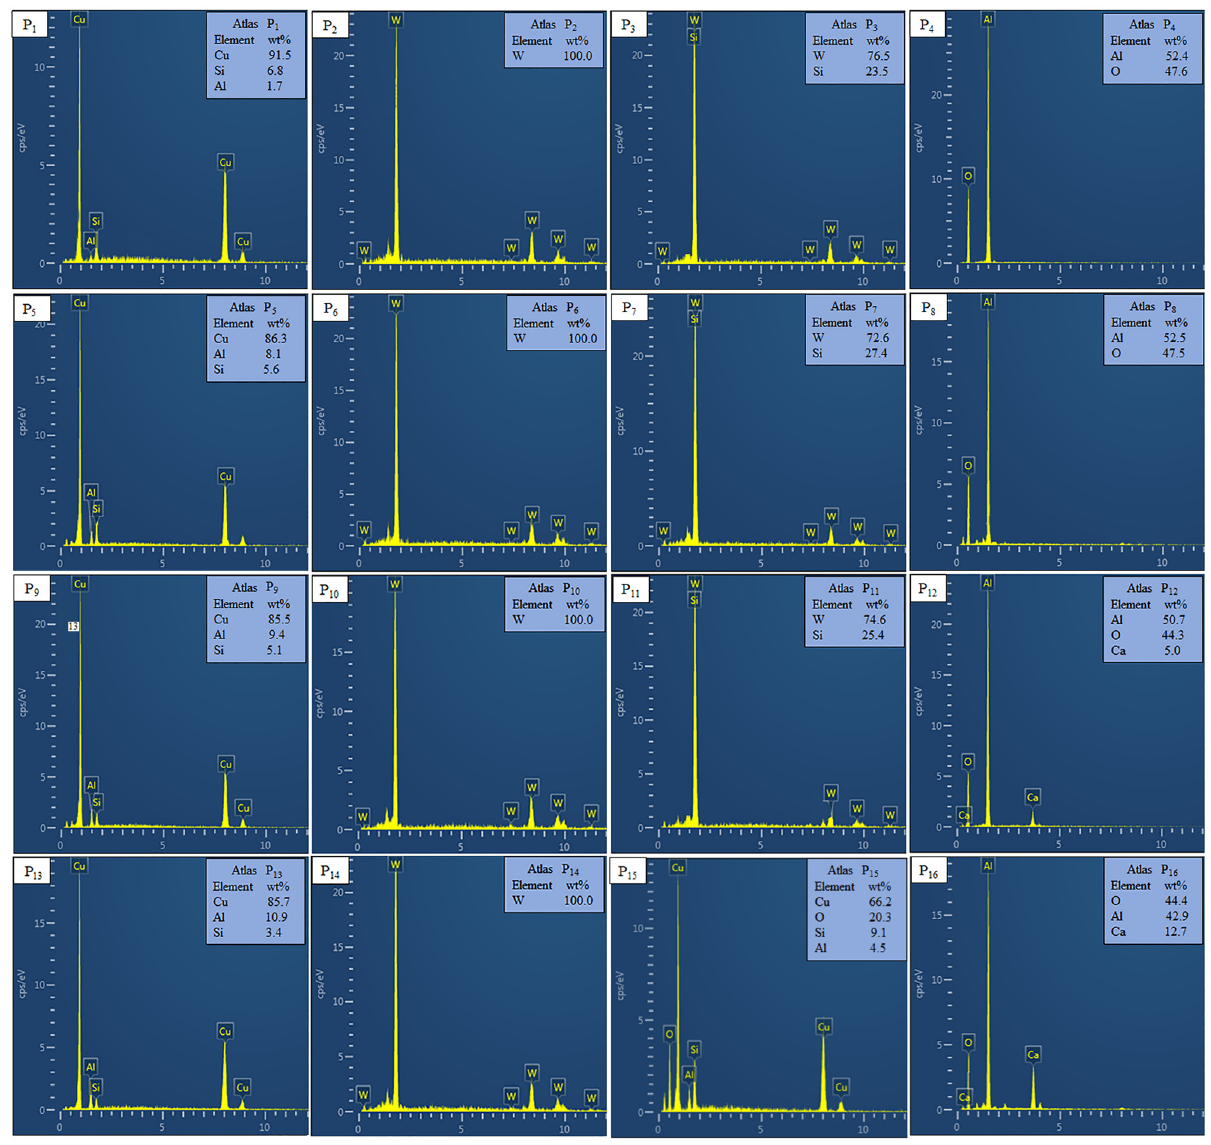
Figure 4: EDS analysis results of the microstructure in the microalloying CuW composites presented in Figure